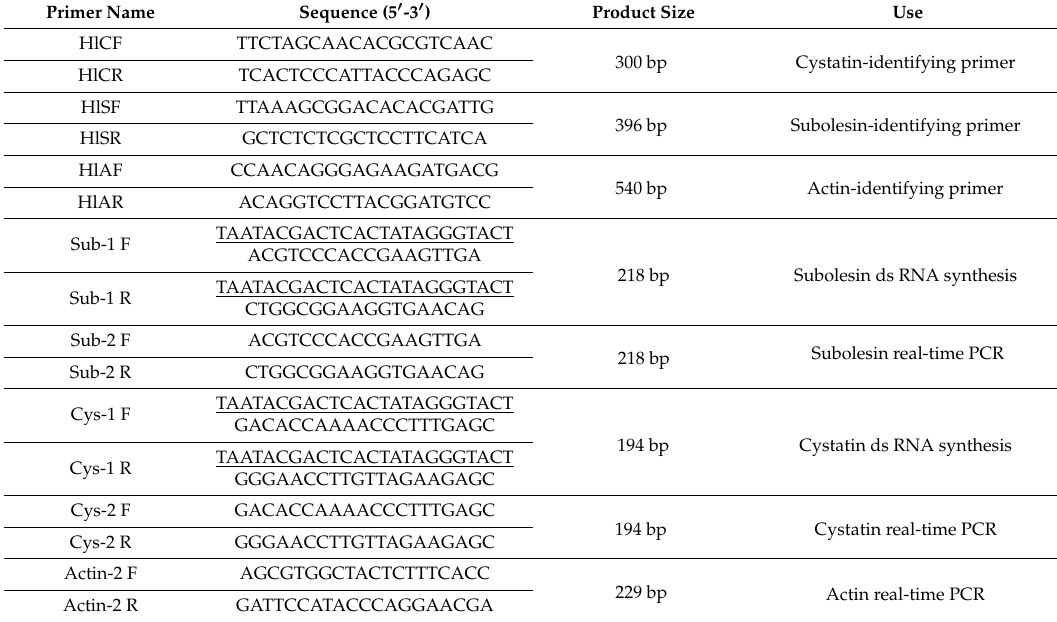
Table 1. Primers used in this